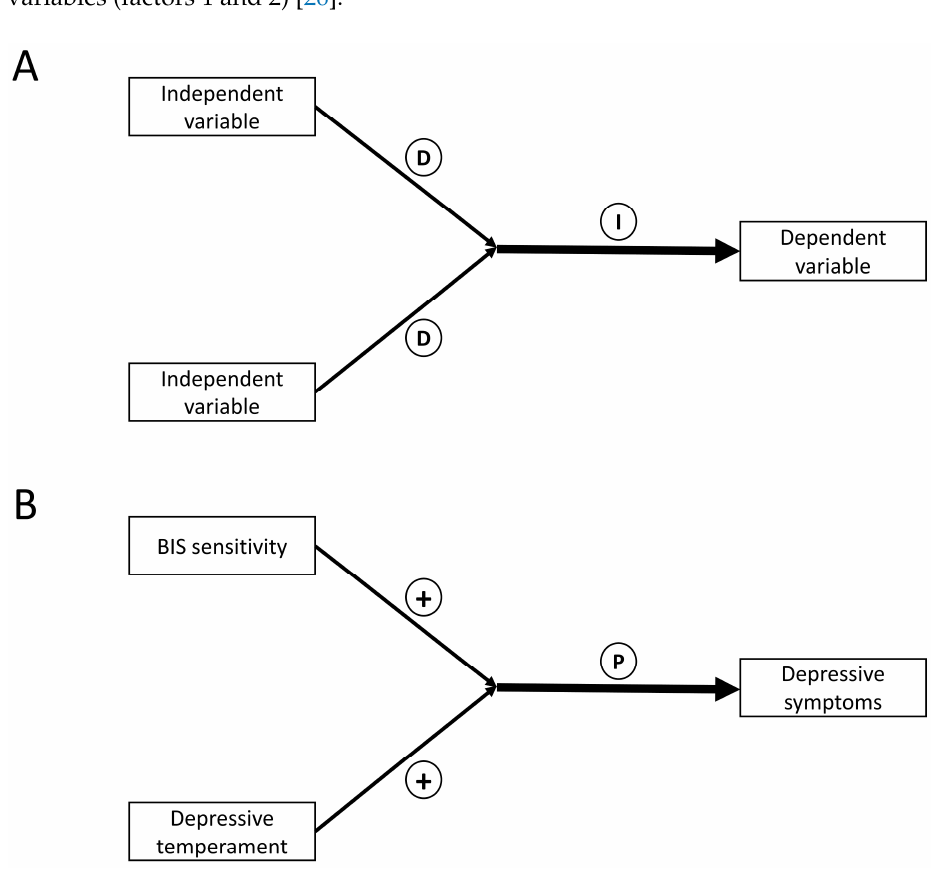
Figure 1. ( A ) Conceptual diagram of the interaction using moderation analysis. ( B ) Effects of the interaction between behavioral inhibition system sensitivity and depressive temperament on depressive symptoms in individuals with major depressive disorder ( N = 90). D, direct effect; I, interaction effect; P, positive interaction effect; +, increasing the severity of depressive